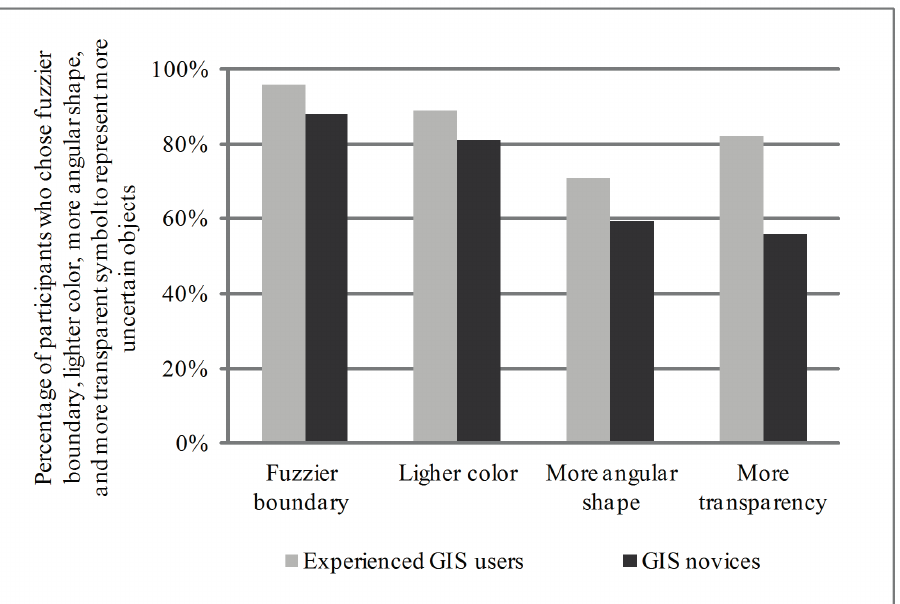
Figure 1. Percentage of participants who prefer different visual variables to represent a high level of